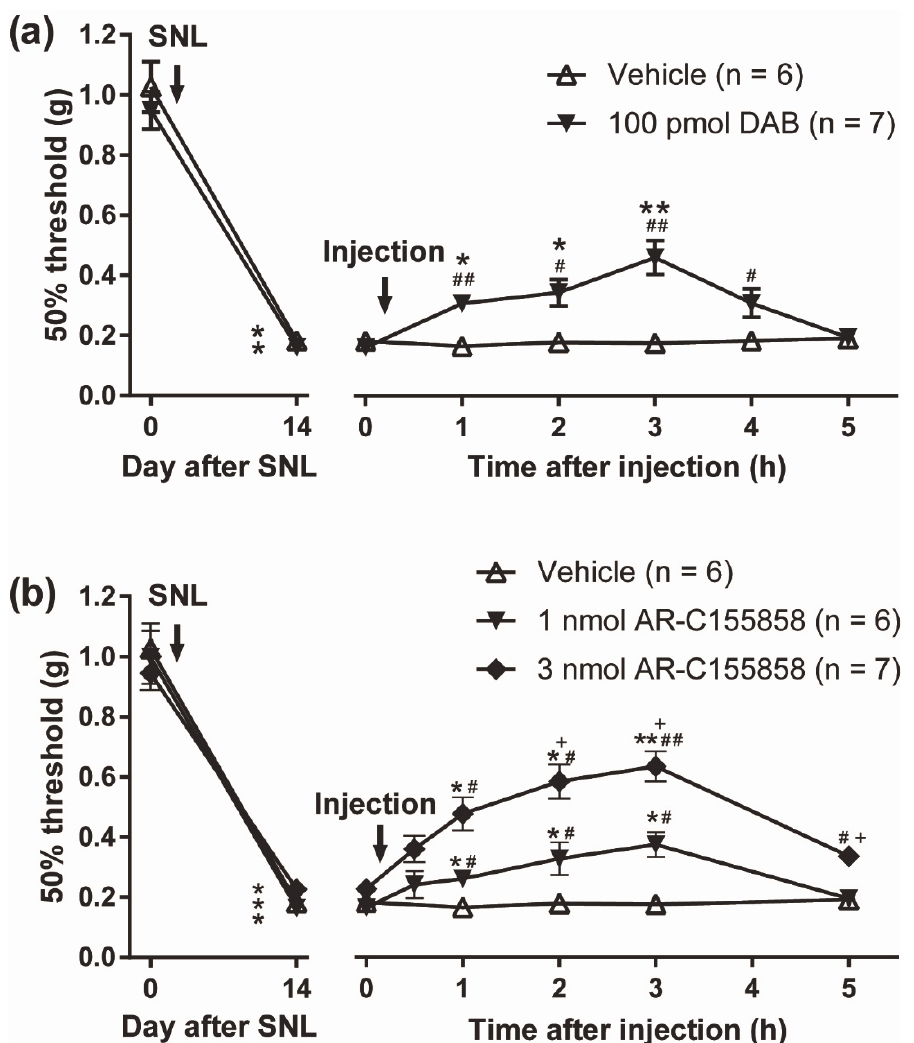
Figure 7. Requirement of spinal ANLS in the maintenance of SNL-induced mechanical allodynia. ( a ) Transient reversal of SNL-evoked mechanical allodynia by intrathecal DAB injection. DAB was injected 14 days after SNL surgery. * p < 0.05 and ** p < 0.01 when compared with Day 0 or time 0 data. # p < 0.05 and ## p < 0.01 when compared with vehicle-treated control. ( b ) Significant anti-allodynic effects of intrathecal AR-C155858 injection on SNL-induced neuropathic pain model mice. AR-C155858 was injected 14 days after SNL surgery. * p < 0.05 and ** p < 0.01 when compared with Day 0 or time 0 data. # p < 0.05 and ## p < 0.01 when compared with vehicle-treated control. + p < 0.05